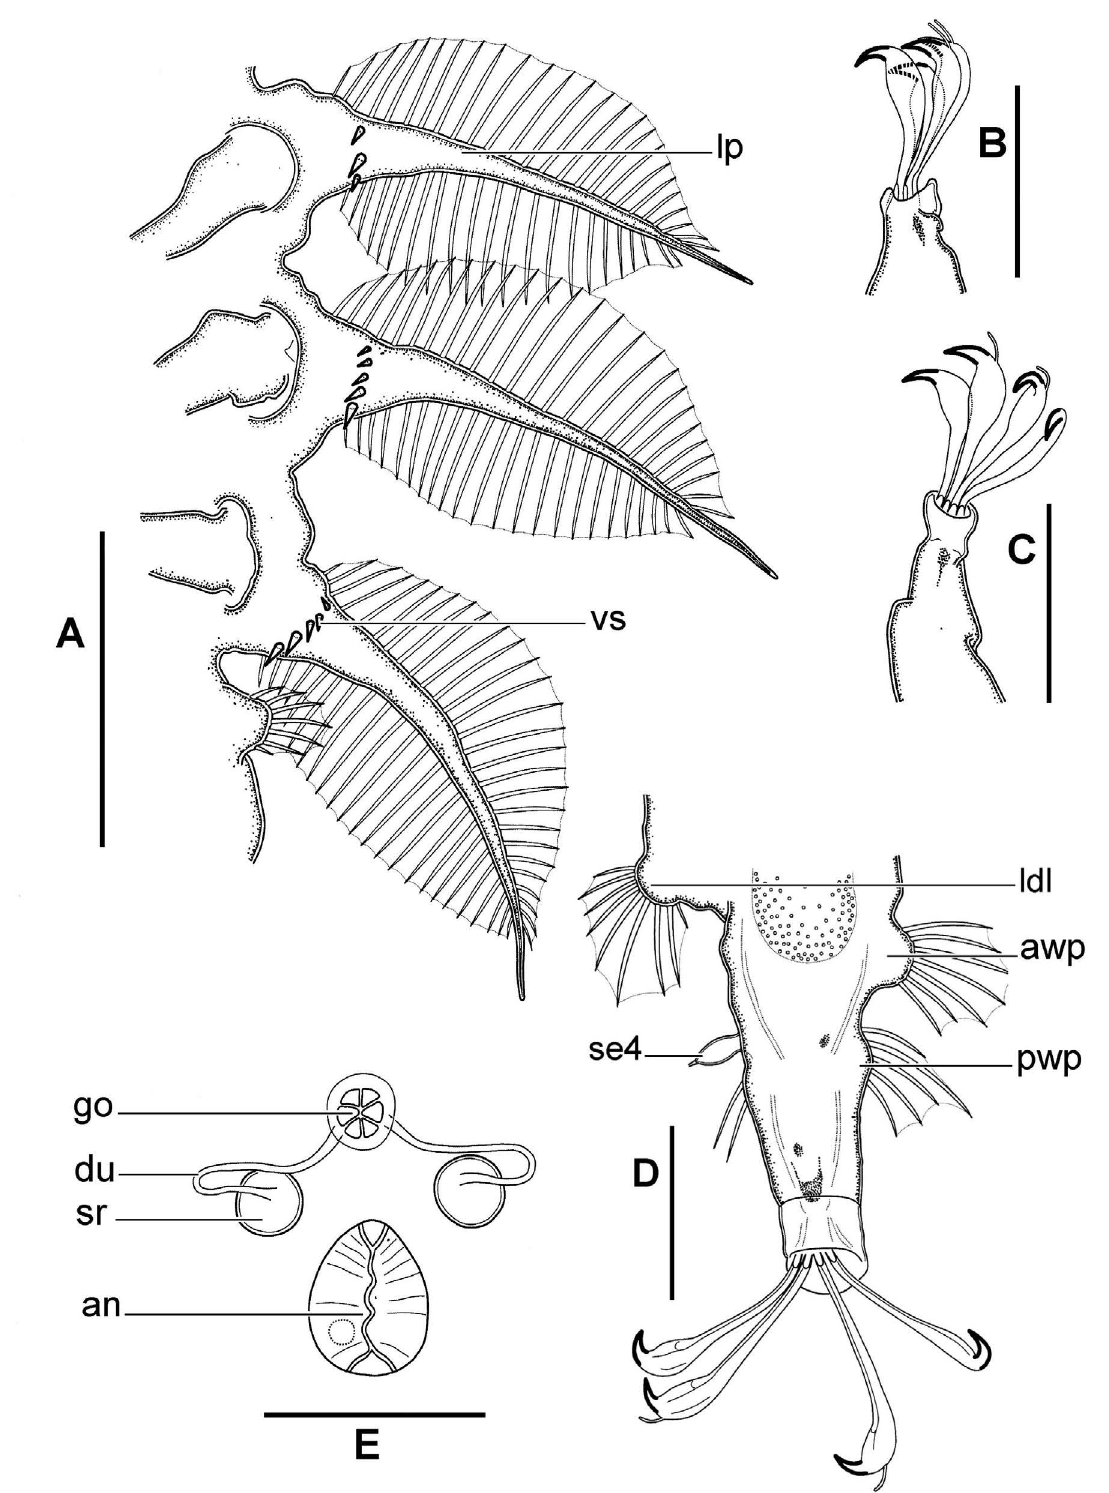
Fig. 5. Neostygarctus grossmeteori sp. nov. Paratype, ♀ (SMF 52), details. A . Lateral body processes, ventral view. B–D . Legs I (left and right) and IV. E . Genital area. Scale bars: A = 50 μm; B–E = 20